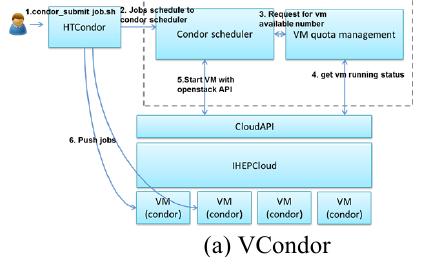
Figure 6. The workflow of VCondor and